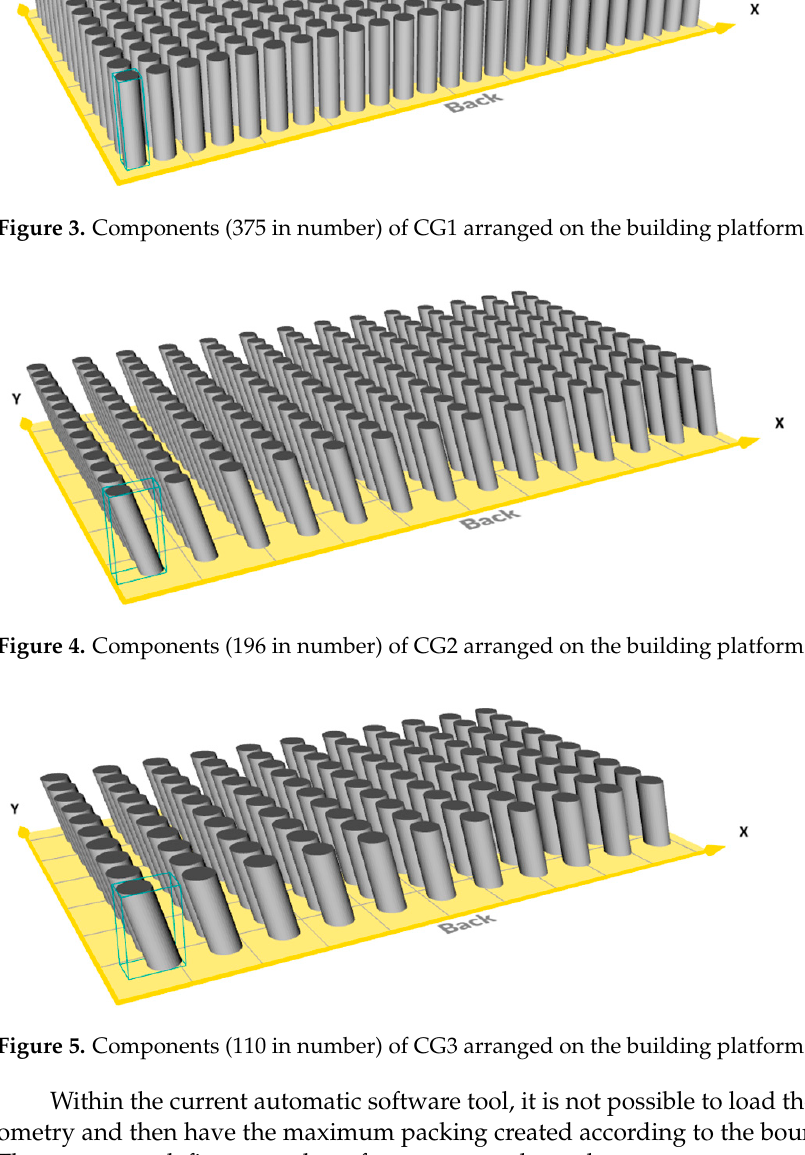
Figure 5. Components (110 in number) of CG3 arranged on the building platform.